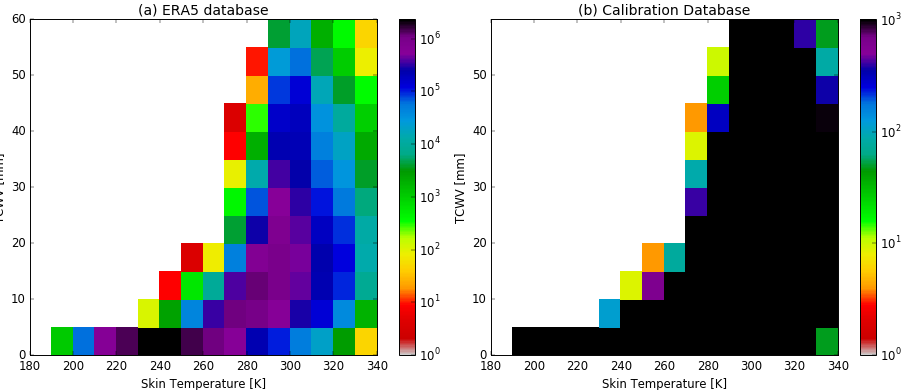
Figure 1. Sample size of the original ERA5 ( a ) and the new calibration ( b ) databases for each TCWV (mm) and skin temperature (K) class.